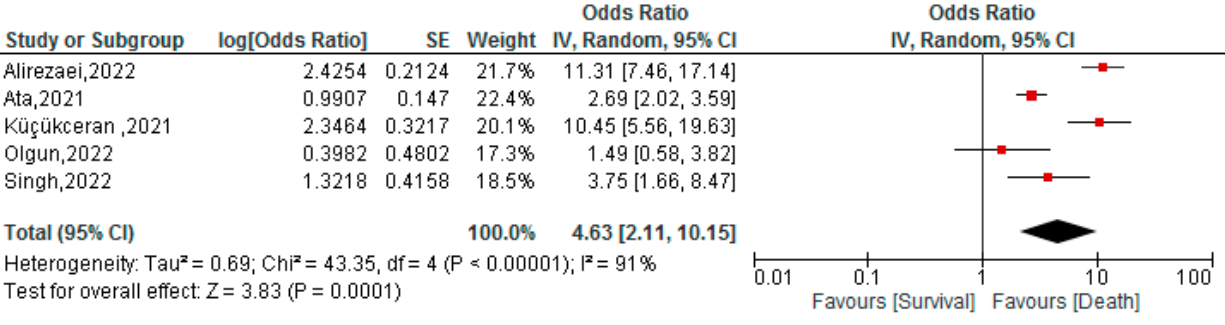
Figure 5. Association between BAR and mortality of COVID-19 patients [46–49,51].